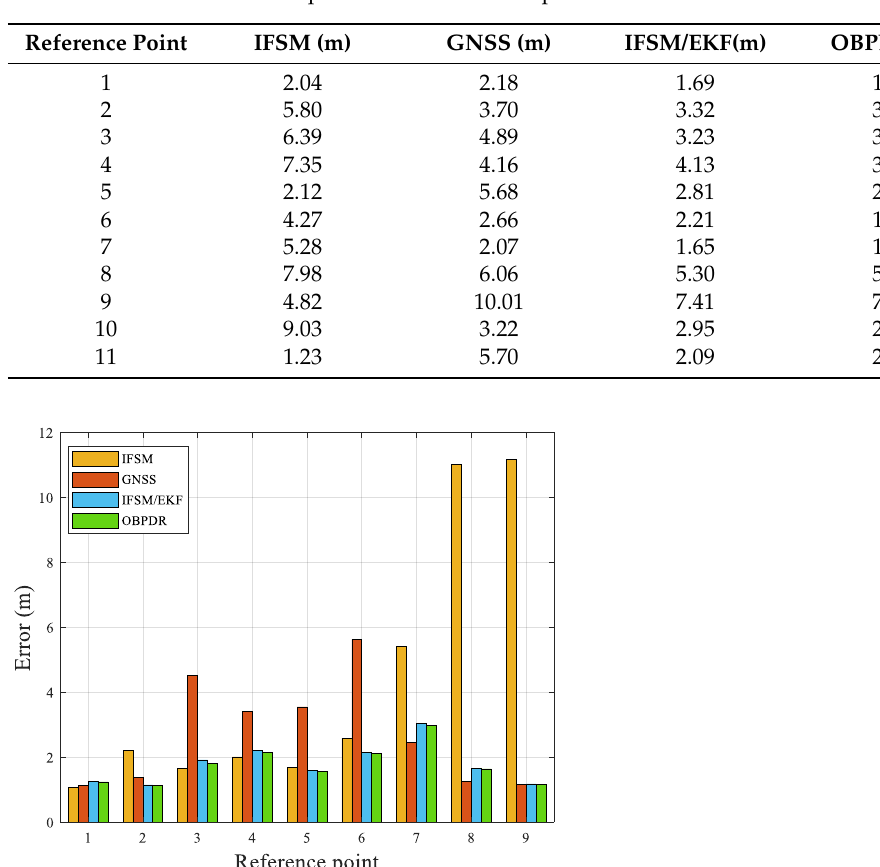
Table 5. Statistics of reference-point errors in shade experiments.